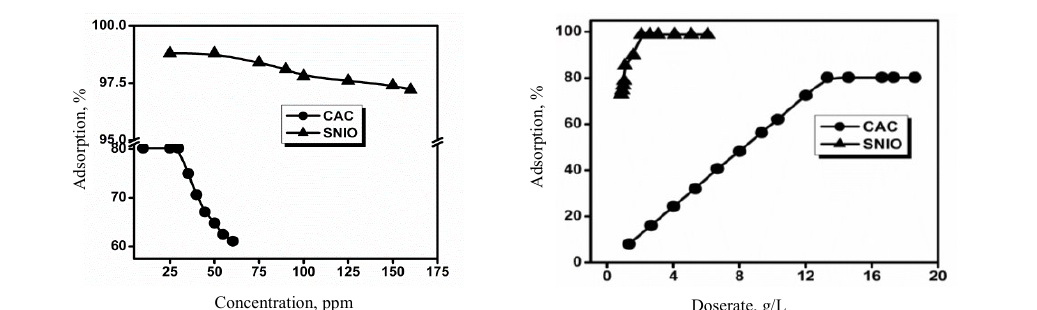
Figure 4. Variation in the percentage removal of the Ni(II) ion by CAC and SNIO with change in the initial concentration (dose rate: 13.3 g/L CAC, 2.57 g/L SNIO; contact time: 60 min; pH 6-6.5).